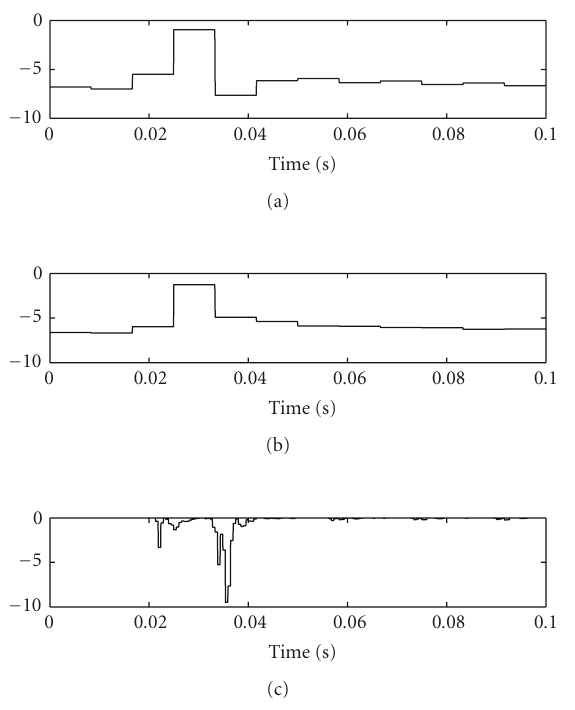
Figure 16: (a) C 4 (0) HOS-based parameter extracted from { x ( n ) } , (b) C 4 (0) HOS-based parameter extracted from { f ( n ) } , (c) C 4 (0) HOS-based parameter extracted from { u ( n ) }